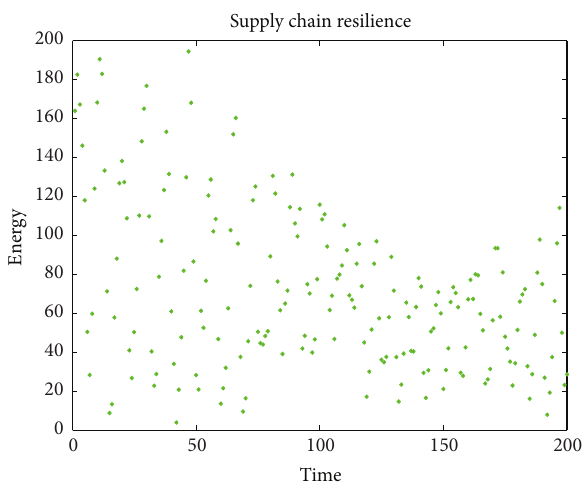
Figure 16: There is resilience within SOC/chemical.